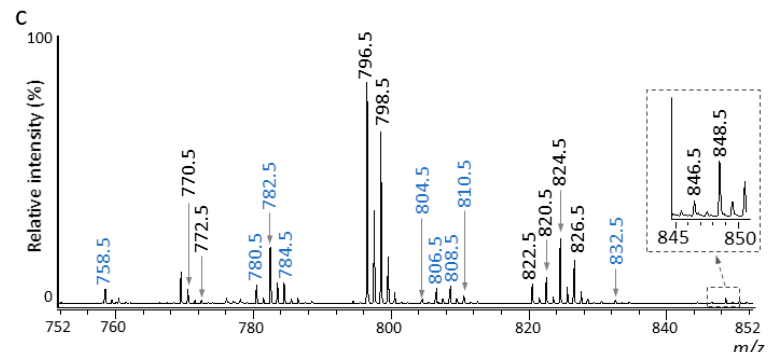
Figure 2. Matrix-assisted laser desorption/ionization–mass spectrometry imaging (MALDI-MSI) analysis of pork chop section. ( a ) Optical image of the pork chop used in the study. Loin, Longissimus thoracis et lumborum muscle. The dotted square line marks the analyzed region. Scale bar represents 10 mm. ( b ) Optical image of pork section prior to MALDI-MSI analysis. Scale bar represents 2 mm. ( c ) The mass spectrum at m/z 752 to 852. Peaks with black m/z values indicate diacyl-phosphatidylcholine (PC) species, while peaks with blue m/z values indicate alkylacyl- and/or alkenylacyl-PC species.